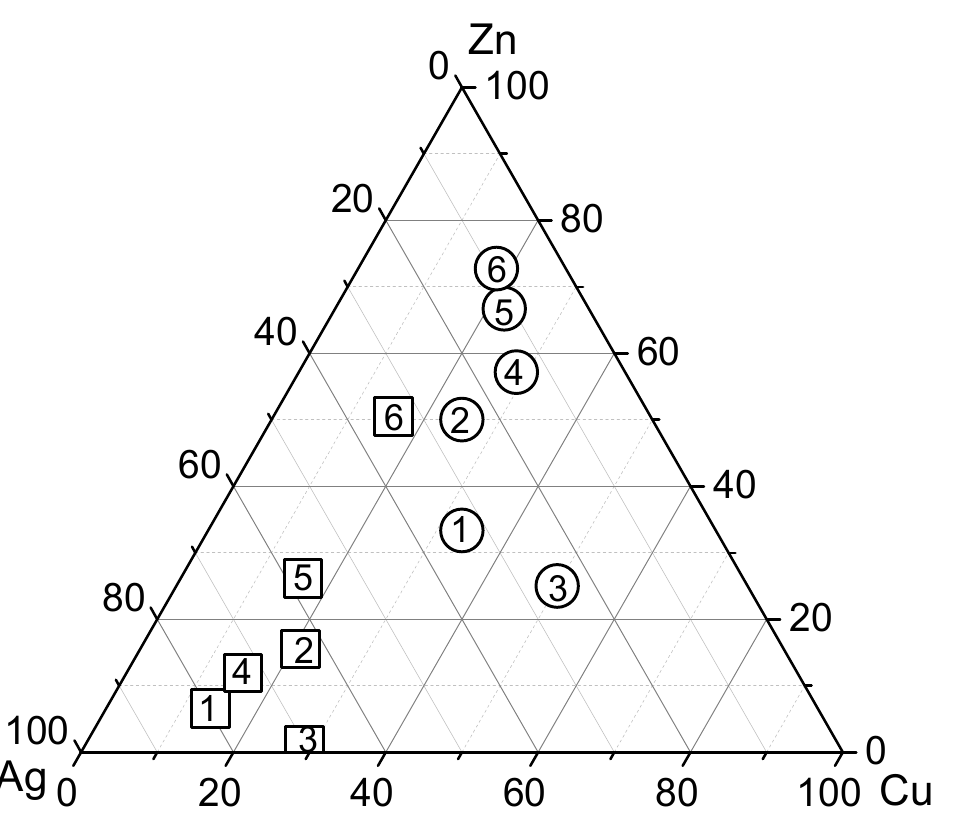
Figure 1. Ternary composition plot for the starting solutions (circles) and obtained samples (squares). Equal numbers denote the compositions for the initial solutions, as well as the samples of zeolites obtained using ion exchange treatment in these solutions: 1—stands for Ag1Cu1Zn1Mor, 2—for Ag1Cu1Zn2Mor, 3—for Ag1Cu2Zn1Mor, 4—for Ag1Cu2Zn4Mor, 5—for Ag1Cu2Zn6Mor, and 6—for Ag1Cu2Zn8Mor. Table 1. Silver, copper, and zinc contents (wt.%) for exchanged samples.